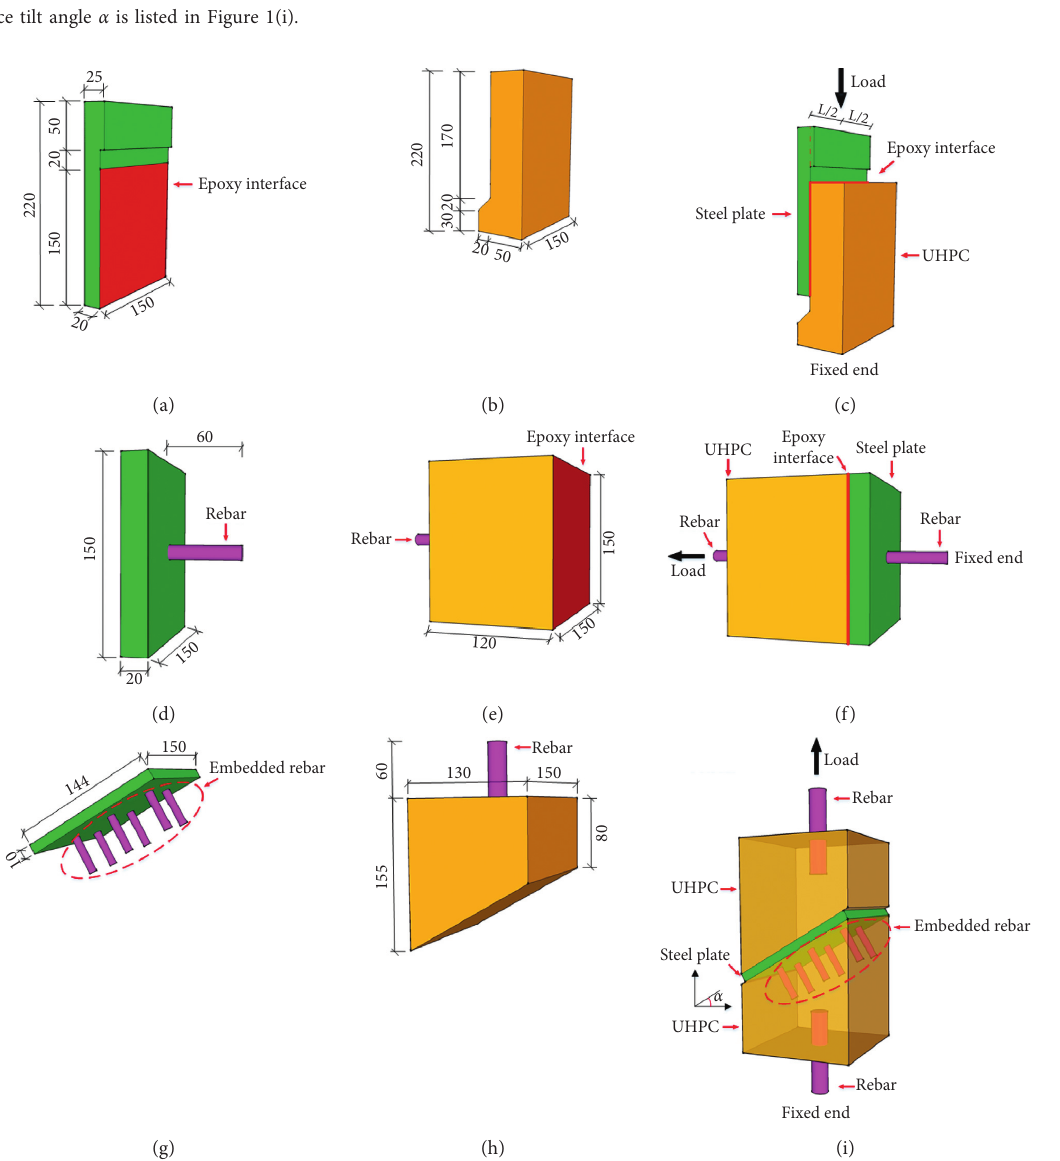
Figure 1: Detailed information of specimen: (a, b, and c) Components and overall structure of specimen PS-E; (d, e, and f) Components and overall structure of specimen PT-E; (g, h, and f) Components and overall structure of ST-E (unit: mm). (a) Steel plate. (b) UHPC. (c) Specimen PS-E. (d) Steel plate. (e) UHPC. (f) Specimen PT-E. (g) Steel plate. (h) UHPC. (i) Specimen